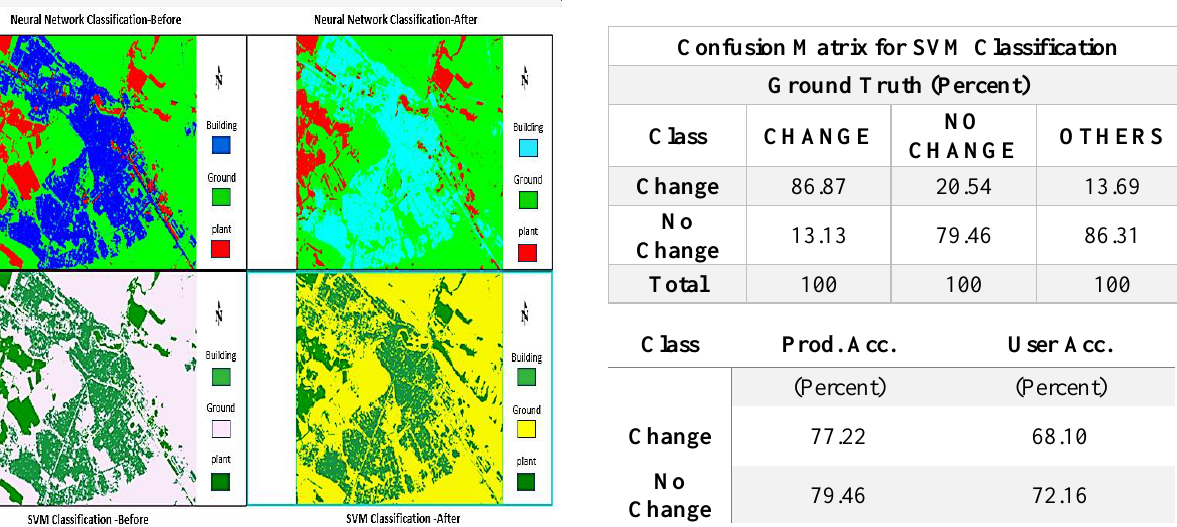
Figure 3. classification of the sentinel images